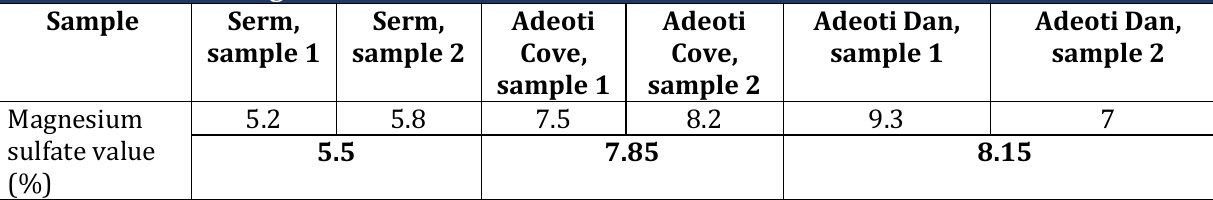
Table 4. Results of Magnesium sulfate soundness